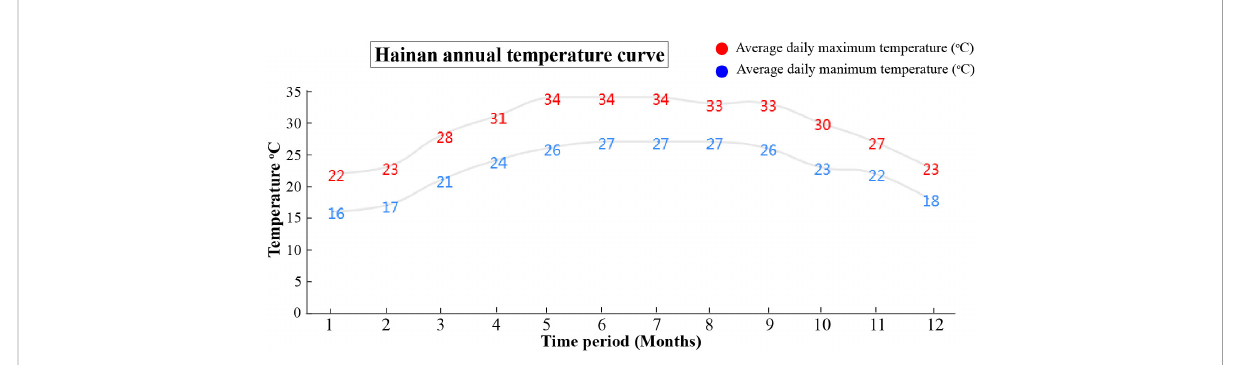
FIGURE 2 The graph showed the daily average high (red) and low (blue) temperatures of Hainan, used in the current study. The numbers of the time period from 1 to 12 expressed the months of data collection